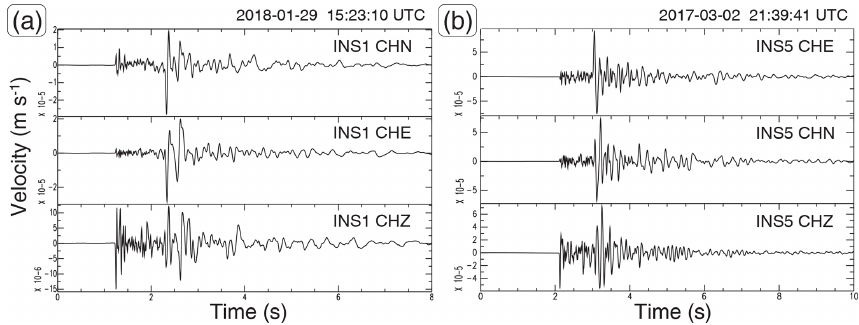
Figure 12. (a) The largest injection induced event ( M l = 1 . 4; lat 40 . 3182 ◦ N, long 15 . 9842 ◦ E; depth = 3 . 50km) recorded by the INS1 seismic station at 1.4km epicentral distance, and (b) the largest reservoir induced event ( M l = 1 . 8; lat 40 . 2723 ◦ N, long 15 . 8840 ◦ E; depth = 4 . 51km) recorded by the INS5 seismic station at 1.9km epicentral distance. At the top of the figures the seismic event origin time is reported. For station INS1 the original horizontal components were rotated anticlockwise by an angle of 307.8 ◦ with respect to the north, according to the computations described in detail in Sect. 2.2. A t s – t p of about 1s can be clearly noticed for both the injection and the reservoir induced events at the correspondent closest